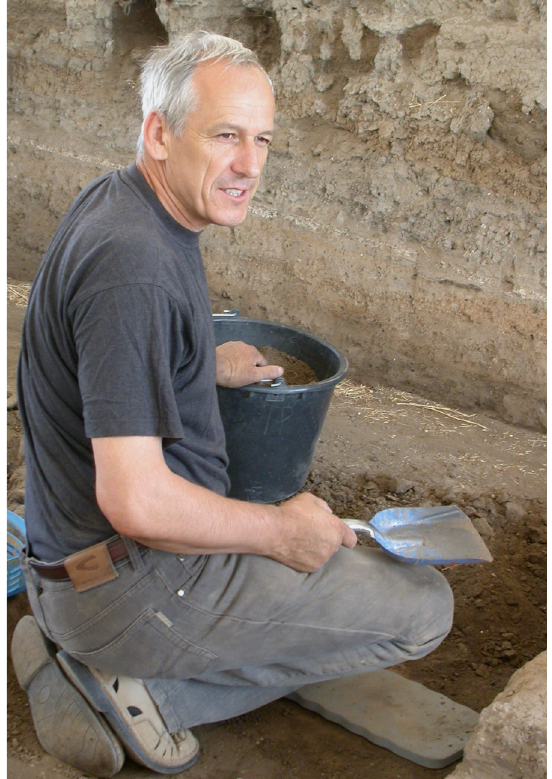
Figure 1: Lech Czerniak at Çatalhöyük, 2006. Photo by J.